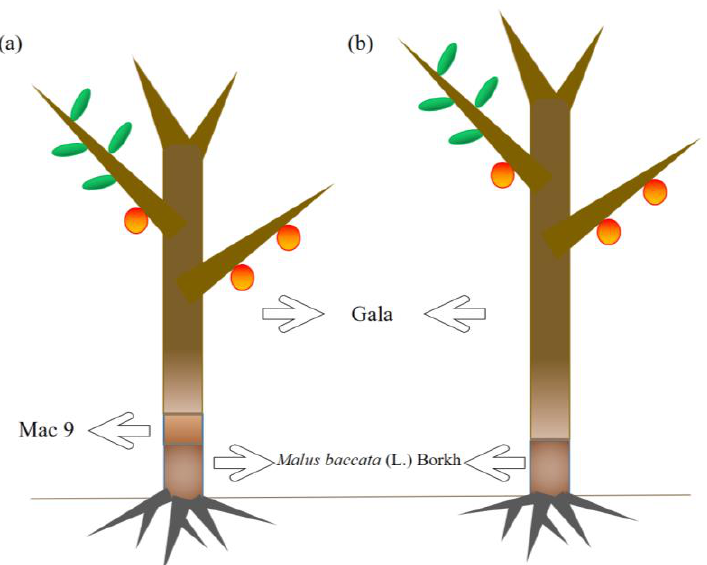
Figure 11. Abridged general view of two grafting combinations. ( a ) ‘Gala’/‘Mac 9’/ Malus baccata (L.) Borkh and ( b ) ‘Gala’/ Malus baccata (L.) Borkh.